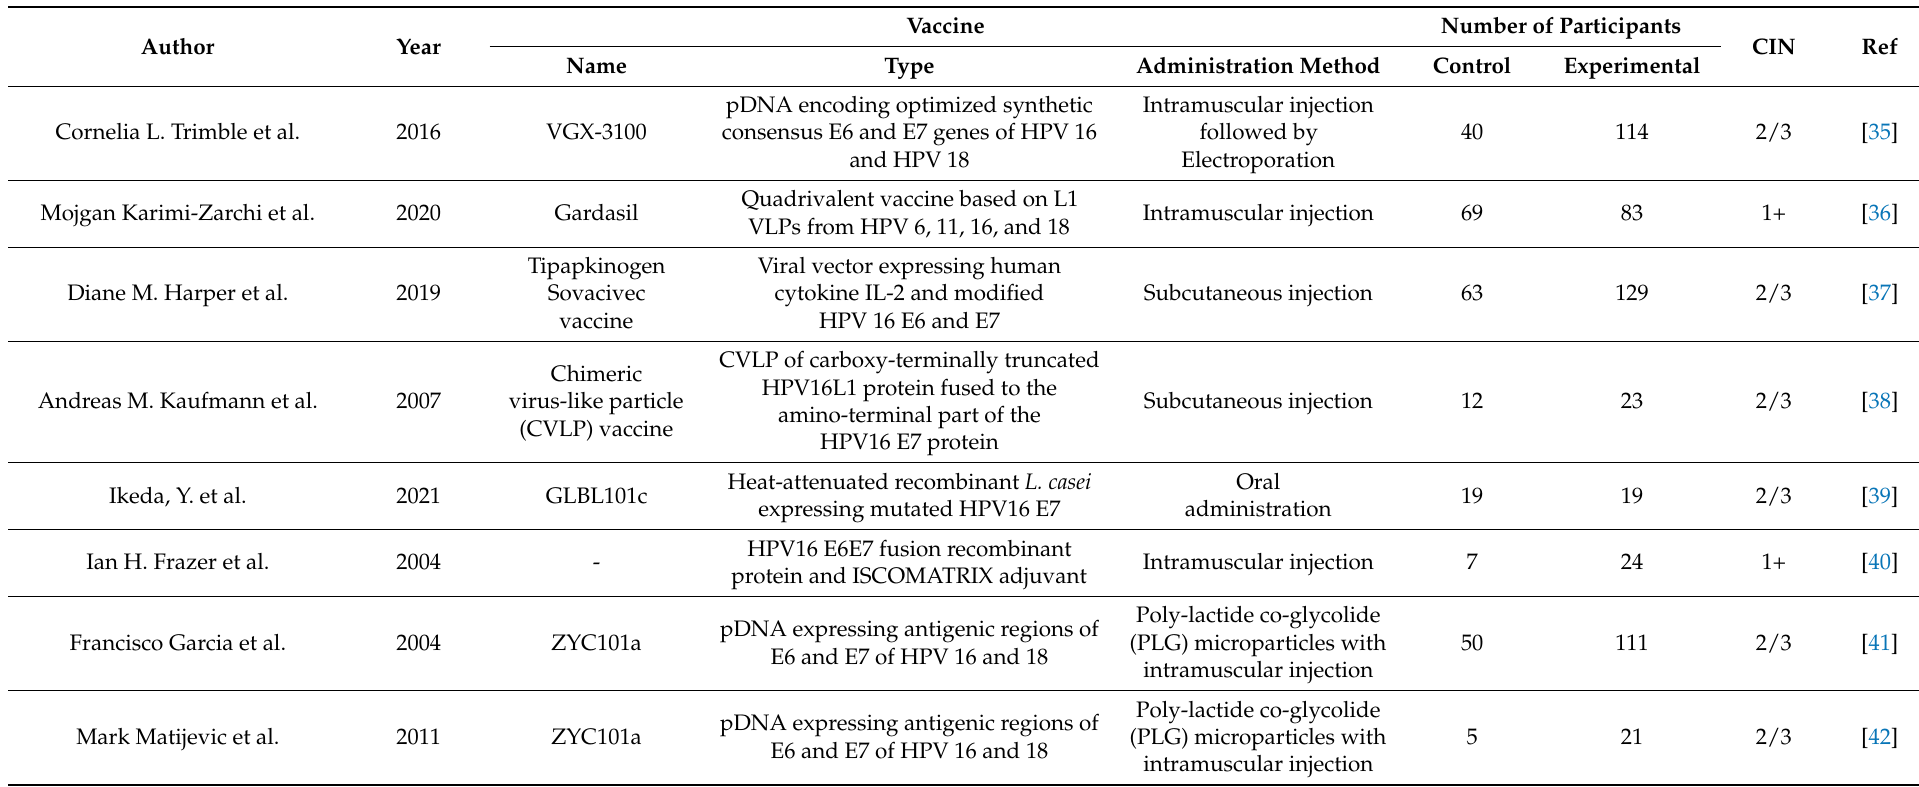
Table 1. Description of the vaccines developed for the regression of CIN 3 selected for this systematic review with